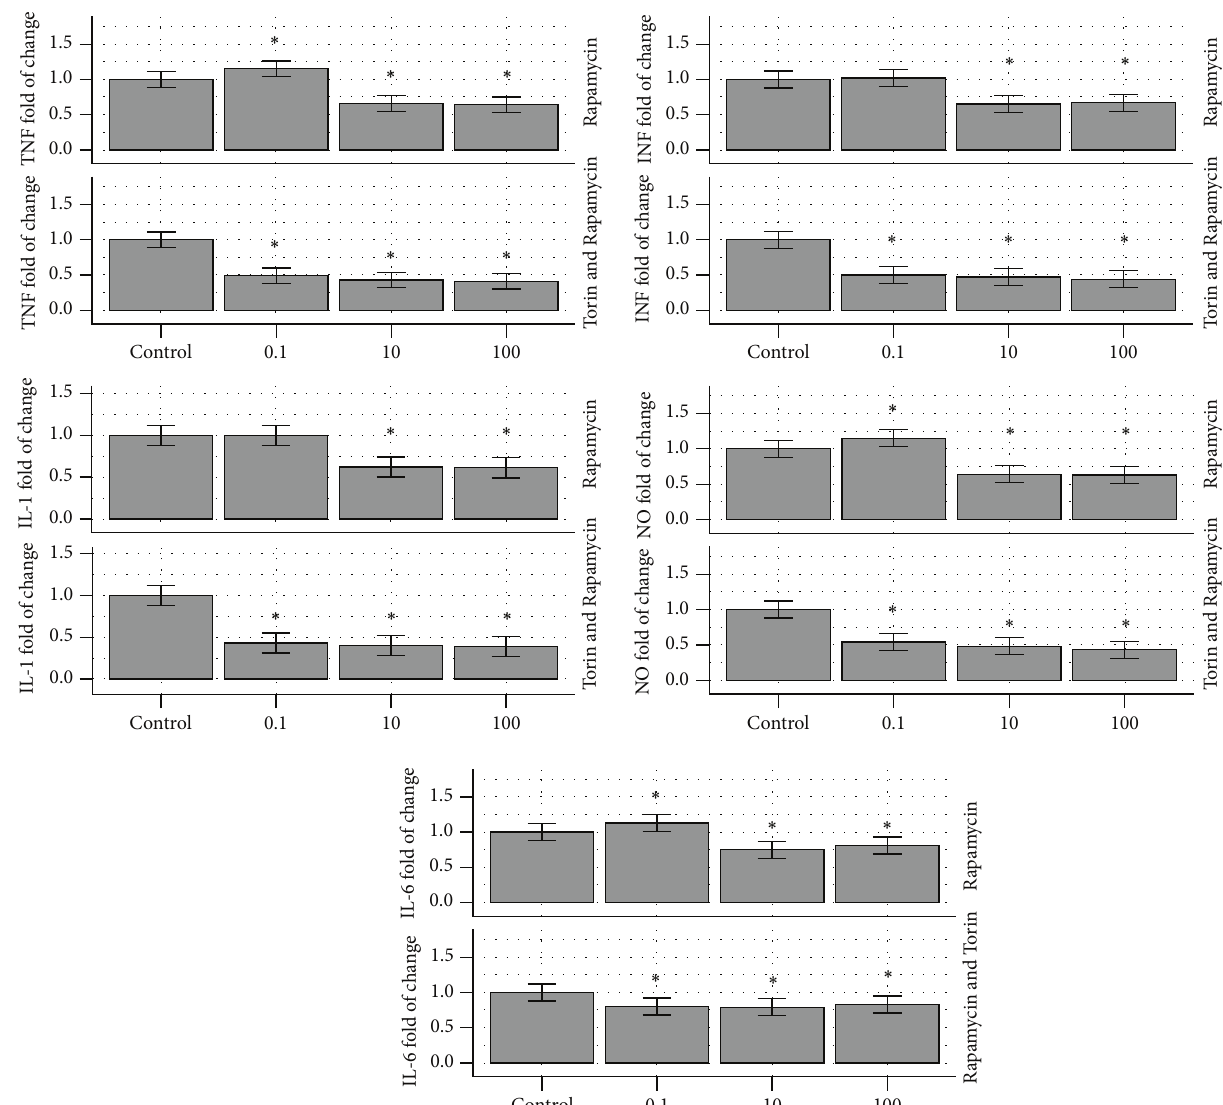
Figure 2: A graphic representation of Table 2. It indicates the reduction from the control of RAW264.7 macrophages inflammatory response of TNF, IL-1, IL-6, INF, and NO, respectively, in the presence of 0, 0.1, 10, and 100ng/mL Rapamycin (up) and Rapamycin and Torin 5 ng/mL (down). The graphs are depicted as a percent of the control response, that is, without Rapamycin (up) or Rapamycin and Torin (down). TNF: tumor necrosis factor, IL-1: interleukin 1, IL-6: interleukin 6, INF: interferon, and NO: nitric oxide.